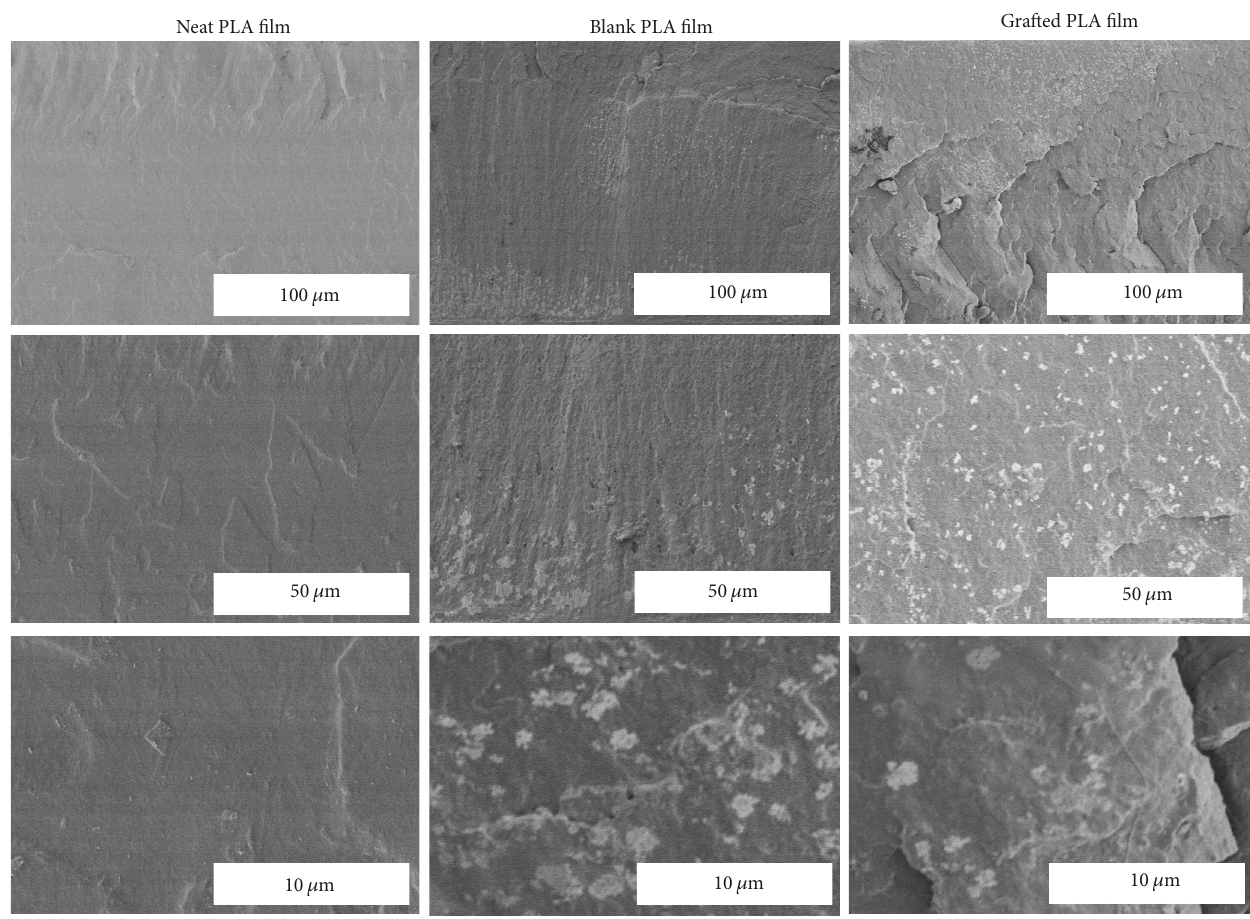
Figure 9: Cross-sectional SEM micrographs of neat, blank, and grafted PLA films at different magnifications.